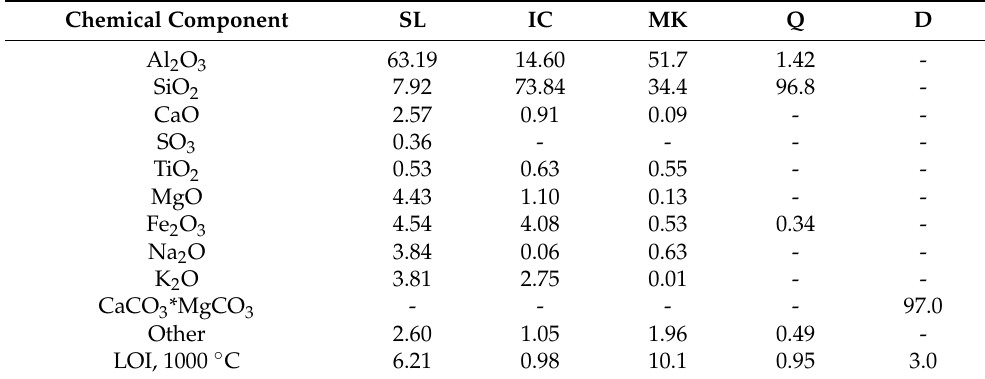
Table 1. Chemical composition of raw materials: SL, IC, MK, Q and D (wt.%). Chemical